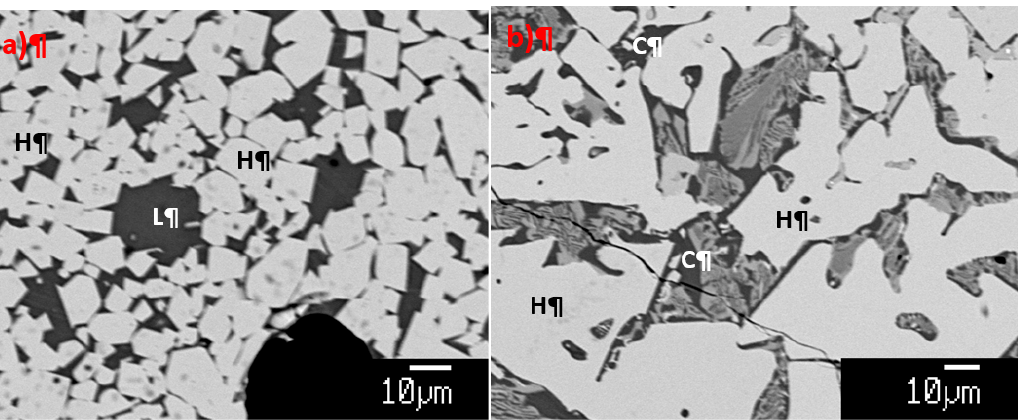
Figure 11. Microstructures of the hematite phase associations, ( a ) equiaxed hematite in a glassy low Ca/SiO matrix, ( b ) angular hematite dendrites surrounded by a partially crystallised matrix (BSE) (H—Hematite, L—Liquid, C—C 2 S). Minerals 2019 , 9 , x FOR PEER REVIEW